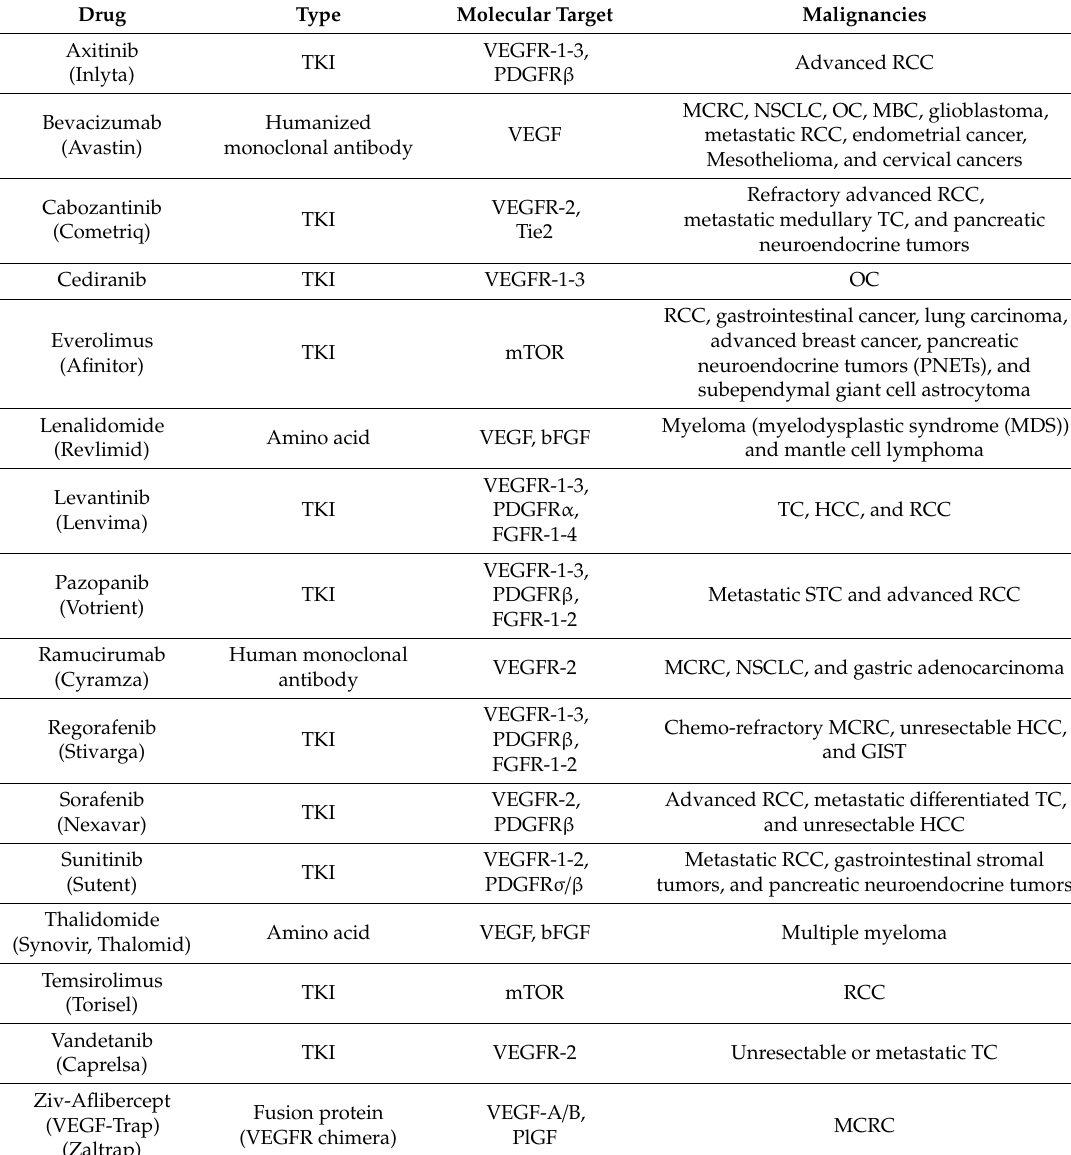
Table 1. Antiangiogenic drugs approved by Food and Drug Administration (FDA) / European Medicines Agency (EMA) for the treatment of solid tumors. Referenced from